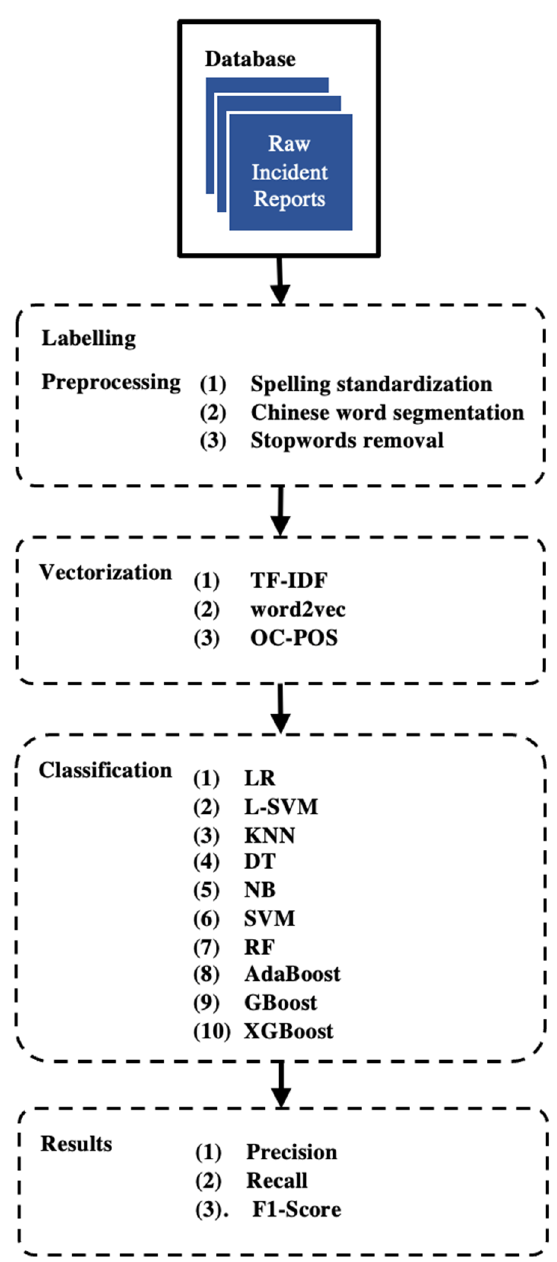
Figure 2. Framework of report classification.